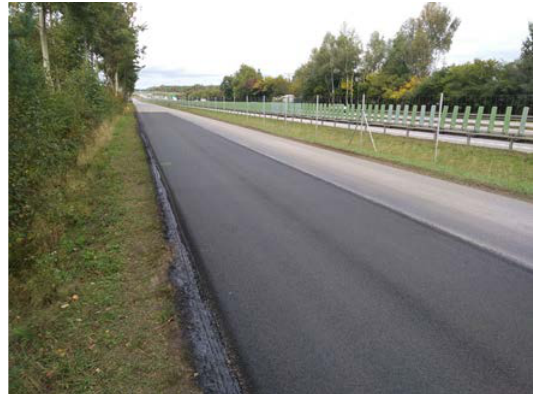
Figure 19. Galaktyczna test section after completion.